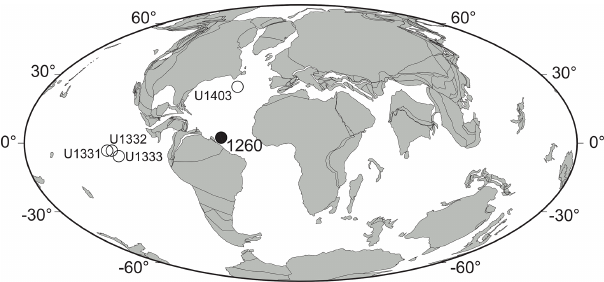
Figure 1. Middle Eocene (ca. 40Ma) paleogeographic map show- ing the location of Demerara Rise (ODP Site 1260, Leg 207) (solid circle) and the four equatorial Pacific and North Atlantic IODP sites used for comparison (open circles). Paleogeographic reconstruction drawn after ODSN Plate Tectonic Reconstruction Service (http:// www.odsn.de/odsn/services/paleomap/paleomap.html, last access: 8 January